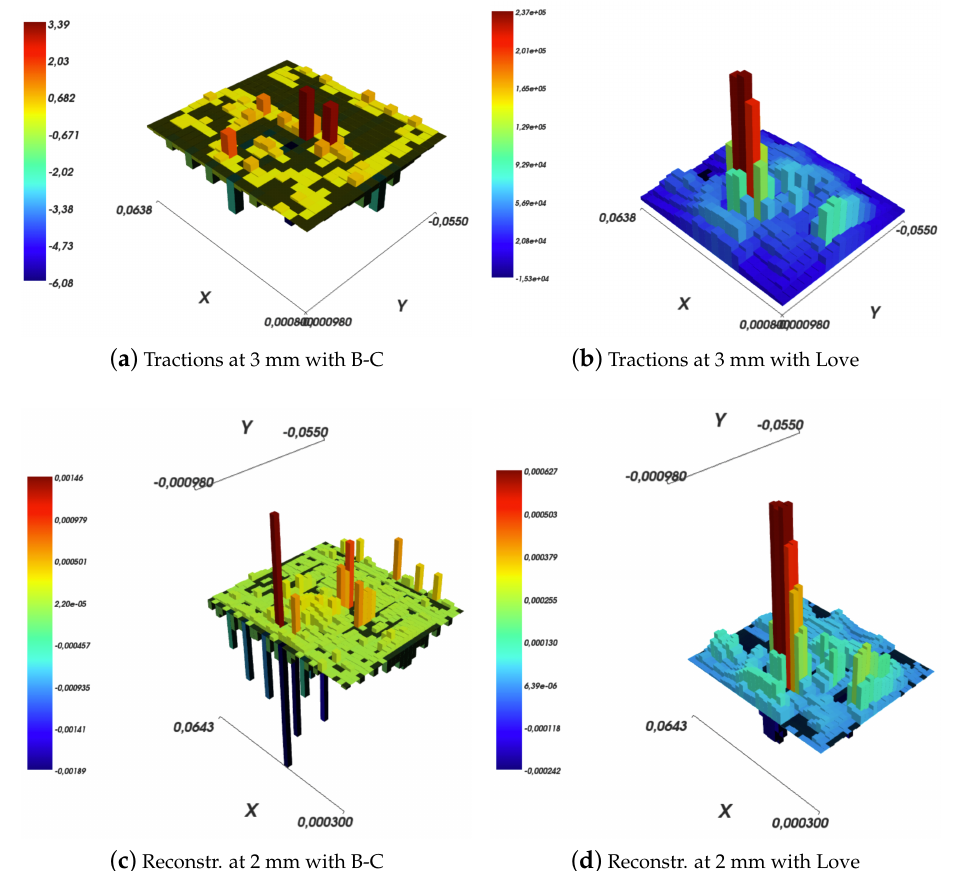
Figure 14. Downsampling of the tractions grid and its influence on the reconstruction. In both cases, tractions are reconstructed on a regular square grid with 3 mm cell resolution. The forward elastic problem is computed for displacements reconstruction on a regular square 2 mm size